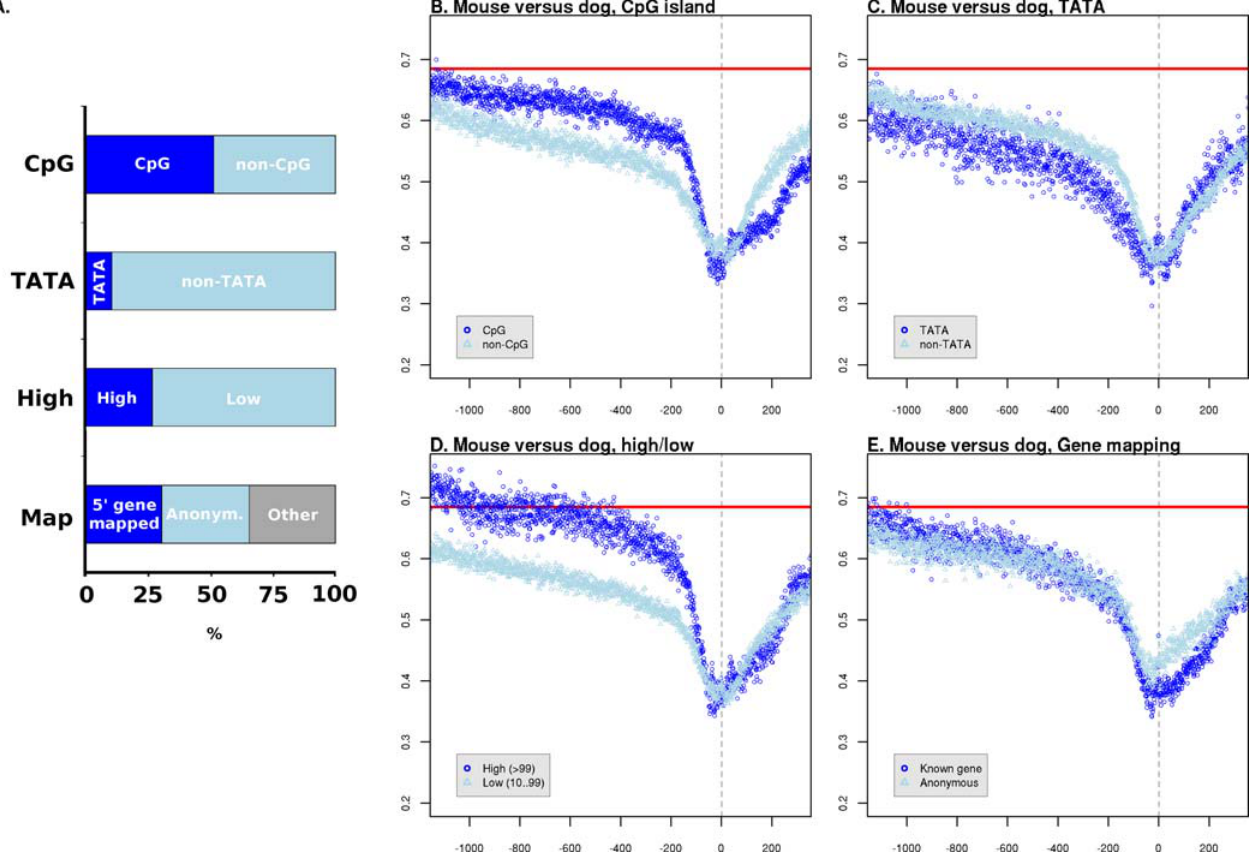
Figure 4. Patterns of Evolution in Promoter Subcategories (A) The percentage of all mouse TSSs assigned to each category. Dark blue shows the percentage assigned to the category annotated to the left, and light blue the reciprocal category (e.g., non-CpG is the reciprocal of CpG). The colour coding is consistent with (B–E). The ‘‘ map ’’ category refers to whether the TSS could be mapped to the annotated 5 9 -most end of a known protein-coding gene (dark blue), could not mapped to a gene (light blue), or maps internally to an annotated gene extent (grey). See Materials and Methods for details of category assignment. (B–E) Single nucleotide resolution estimates of substitution rates calculated from promoters assigned to the indicated categories. Only rates calculated from mouse–dog comparisons are shown. The 95% confidence intervals have been excluded for clarity. Red horizontal lines show K for ARs, nucleotide position is shown on the x- axis relative to the TSS at þ 1 (grey vertical line), and K is shown on the y- axis. Although there are three categories indicated for gene mapping in (A), only two are shown for clarity. DOI: